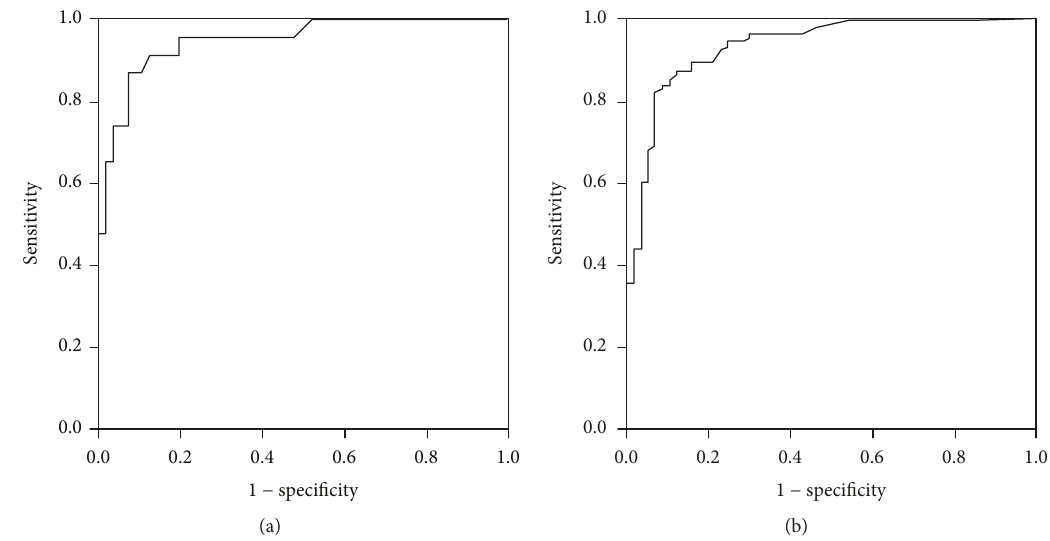
Figure 1: ROC curve to identify T1DM from non-T1DM. (a) The ROC curve identi fi ed a cut ‐ off UCPCR ≥ 0 21 nmol/mmol for discriminating monogenic diabetes from T1DM (AUC 0.949) with 87% sensitivity and 93% speci fi city. (b) The ROC curve identi fi ed a cut ‐ off UCPCR ≥ 0 20nmol/mmol for discriminating T2DM from T1DM (AUC 0.932) with 82% sensitivity and 93% speci fi